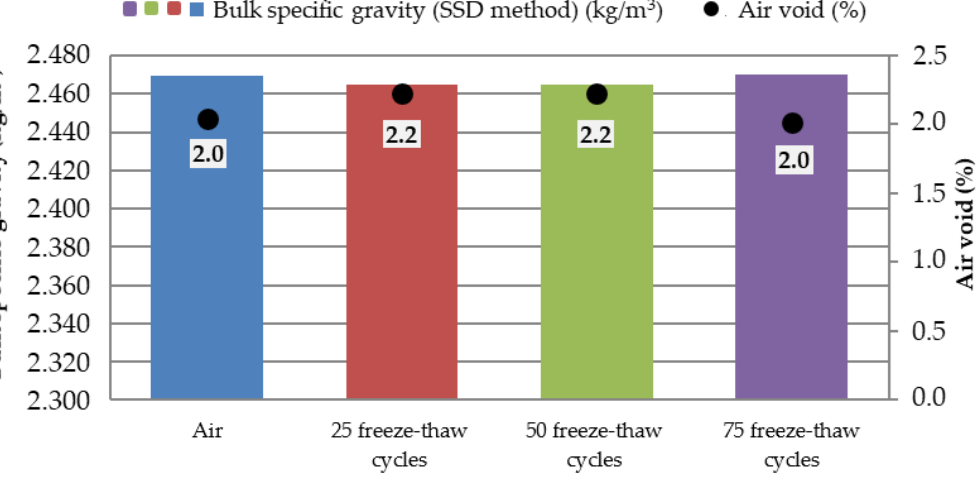
Figure 7. Bulk specific density and air void of the ACO 11 + mixture depending on the number of freeze – thaw cycles.